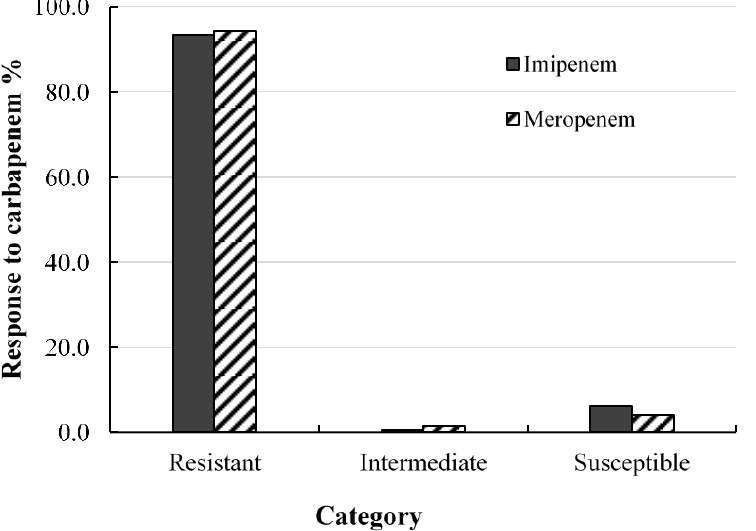
Figure 1. Screening for antibacterial activity of carbapenems (imipenem and meropenem) against clinical Acinetobacter baumannii isolates, determined using disc diffusion method.